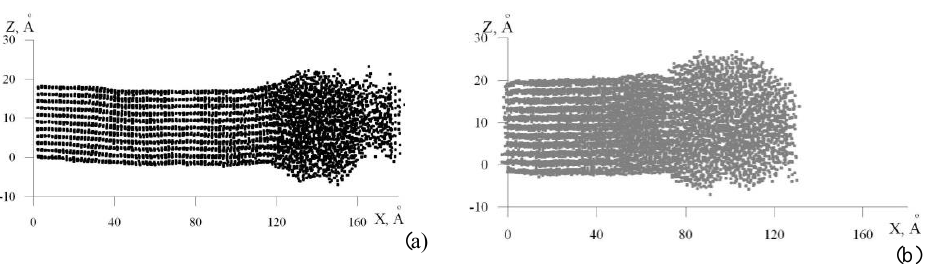
Fig. 13. Outlook of the initially perfect nanorod (а) at the time instant 50 ps and amorphized nanorod (b).